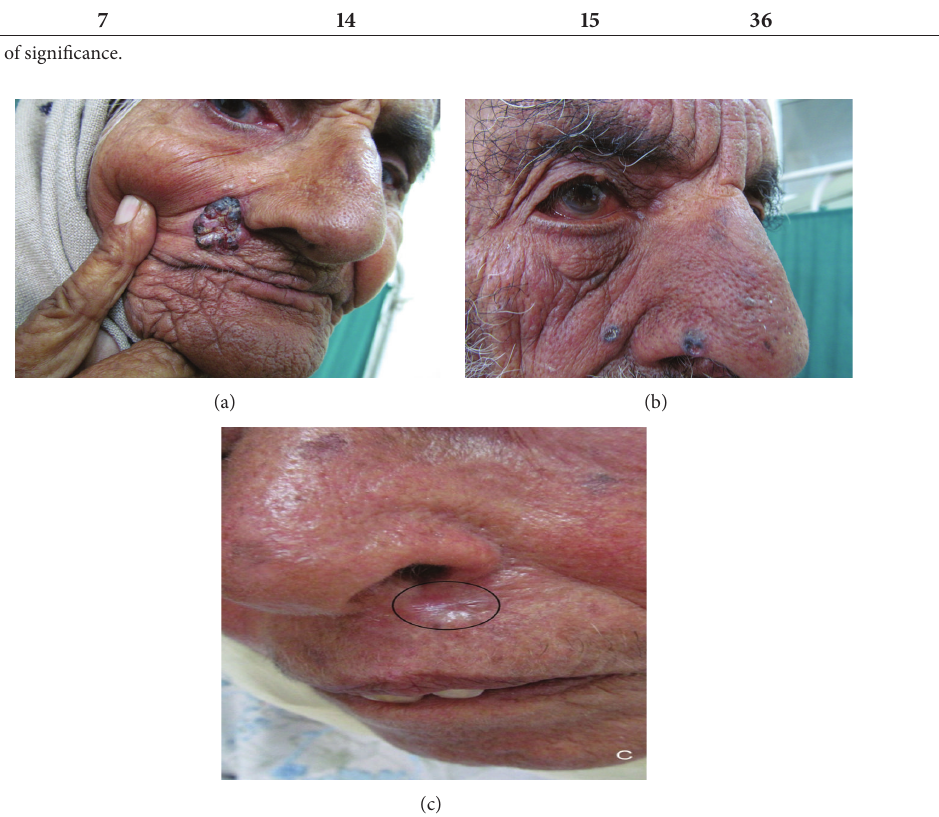
Figure 2: (a) Noduloulcerative, pigmented BCC in an elderly female. (b) Multiple, pigmented papular BCC on face. (c) Morpheaform BCC in an elderly woman.